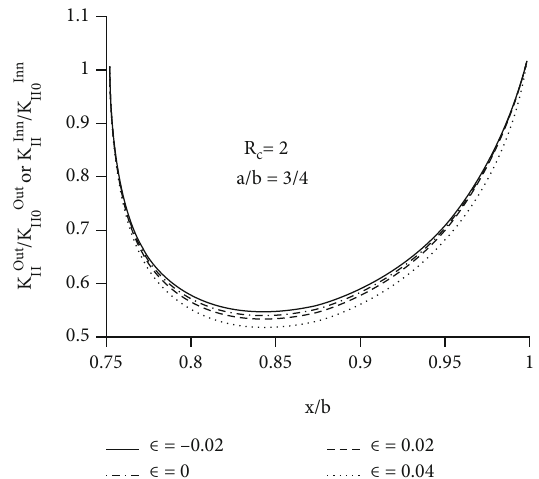
/ Q 1 c 1 versus x